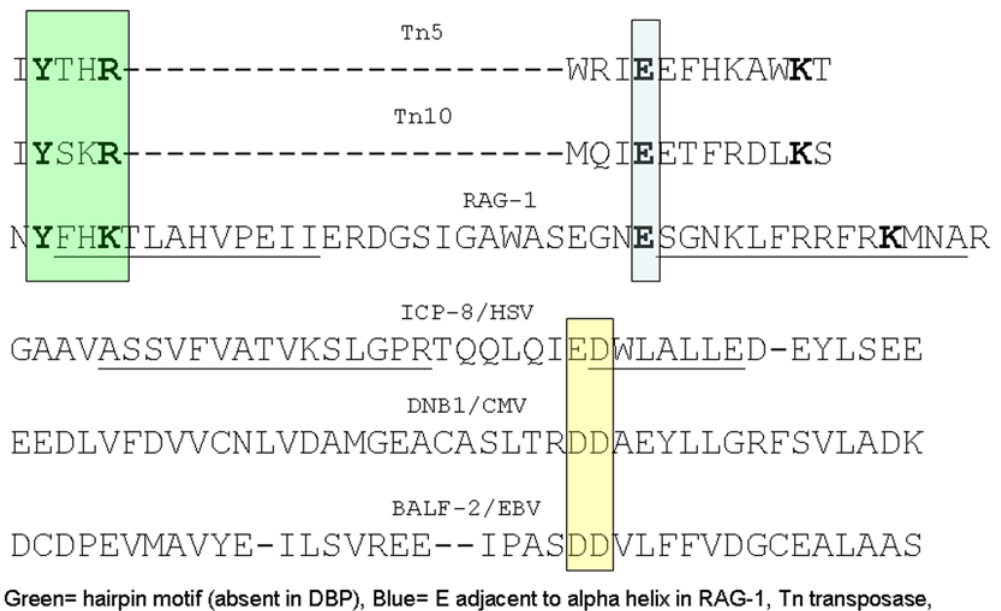
Figure 8. Conserved Functional DDE residues between transposases, RAG proteins and herpes DBP. Despite primary ‘‘low information content’’ amino acid sequence divergence of intervening sequences, RAG-1 proteins encode a ‘‘high information content’’ absolutely conserved E residue adjacent to a conserved alpha helix in the extreme carboxyl terminus of the protein shared with prokaryotic transposons (Tn5 and Tn10). This functionally conserved residue is required for RAG-1 magnesium ion binding and protein function. Similarly, despite primary amino acid sequence divergence of intervening regions all herpes DBP encode a conserved D/E residue adjacent to a conserved alpha helix in the DNA-binding carboxyl terminus of the protein. These high information content similarities are consistent with and support descent of both proteins from a common precursor recombinase.